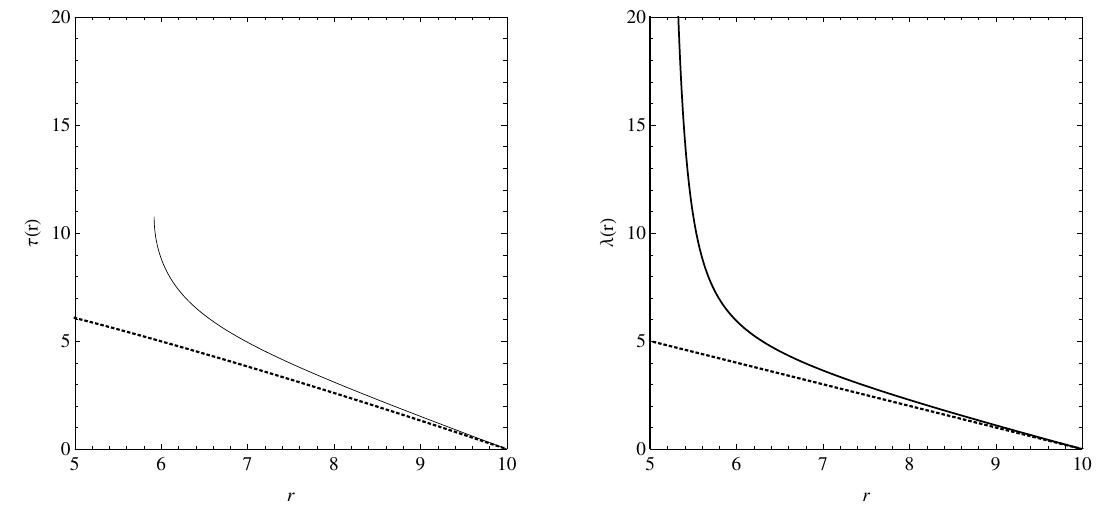
Figure 1 . Left panel: proper time (cid:28) as a function of the radial coordinate r of a massive particle with vanishing angular momentum moving to smaller radii from the initial coordinate r = r in . The solid line corresponds to the proper time in the rescaled metric and the particle cannot reach the surface r = r sing . The dashed line corresponds to the standard JNW metric in Einstein’s gravity. Right panel: as in the left panel for the a(cid:14)ne parameter (cid:21) of a massless particle. In these plots, we assume E = M = L = 1, n = (cid:22) = 2, and r in =